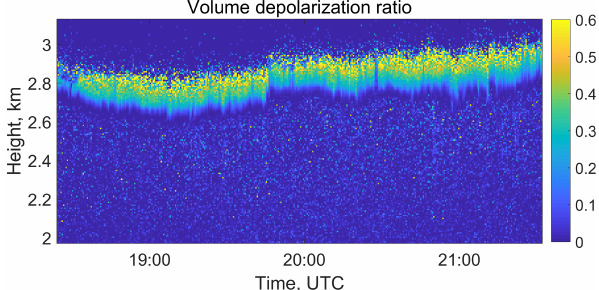
Figure 8. Volume linear depolarization ratio for the entire 3h pe- riod, shown in Fig. 4. The temporal resolution is